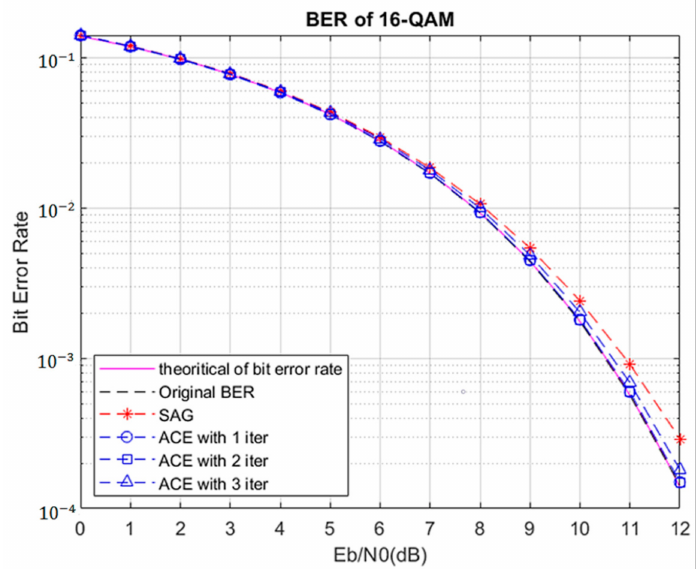
Figure 9. BER performance of the 16QAM–OFDM with the SAG method compared with the ACE